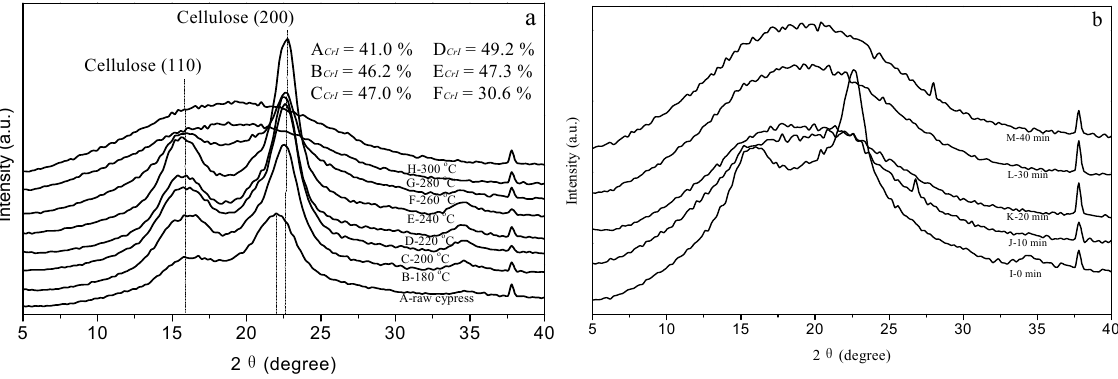
Figure 3. X-ray diffraction patterns of the raw cypress before and after hydrothermal liquefaction: ( a ) the raw cypress before and after hydrothermal liquefaction at different temperatures; and ( b ) the raw cypress after hydrothermal liquefaction at different retention